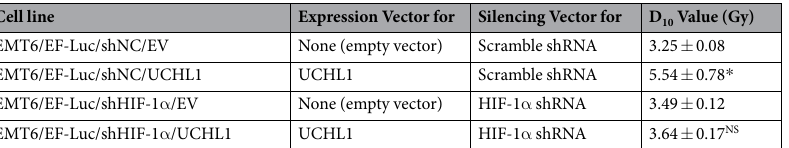
(GSS) 49 , and the reduction of glutathione-S-S-glutathione (GSSG) to GSH by glutathione-disulfide reductase (GSR), which uses NADPH as an electron donor 49 . Because NADPH is known to be provided as a byproduct of the pentose-phosphate pathway (PPP) 17, 18 , our result that UCHL1 overexpression increased radioresistance by producing GSH through the accelerated glycolysis and PPP is reasonable. The UCHL1-dependent increase in the intracellular GSH levels was significantly suppressed by silencing the expression of a key molecule of the pentose phosphate pathway, the glucose-6-phosphate dehydrogenase X-linked (G6pdx) gene 17, 18 . Moreover, silencing the HIF-1 α gene completely abrogated the UCHL1-mediated radiore- sistance of cancer cells. Based on these findings, our study provides an insight into a novel strategy targeting G6pdx and HIF-1 α to overcome the UCHL1-dependent radioresistance of cancer cells. Our clonogenic cell survival assays and the quantitative analysis of metabolite levels collectively demonstrated that the UCHL1-mediated radioresistance was at least in part dependent on the antioxidant property of cancer